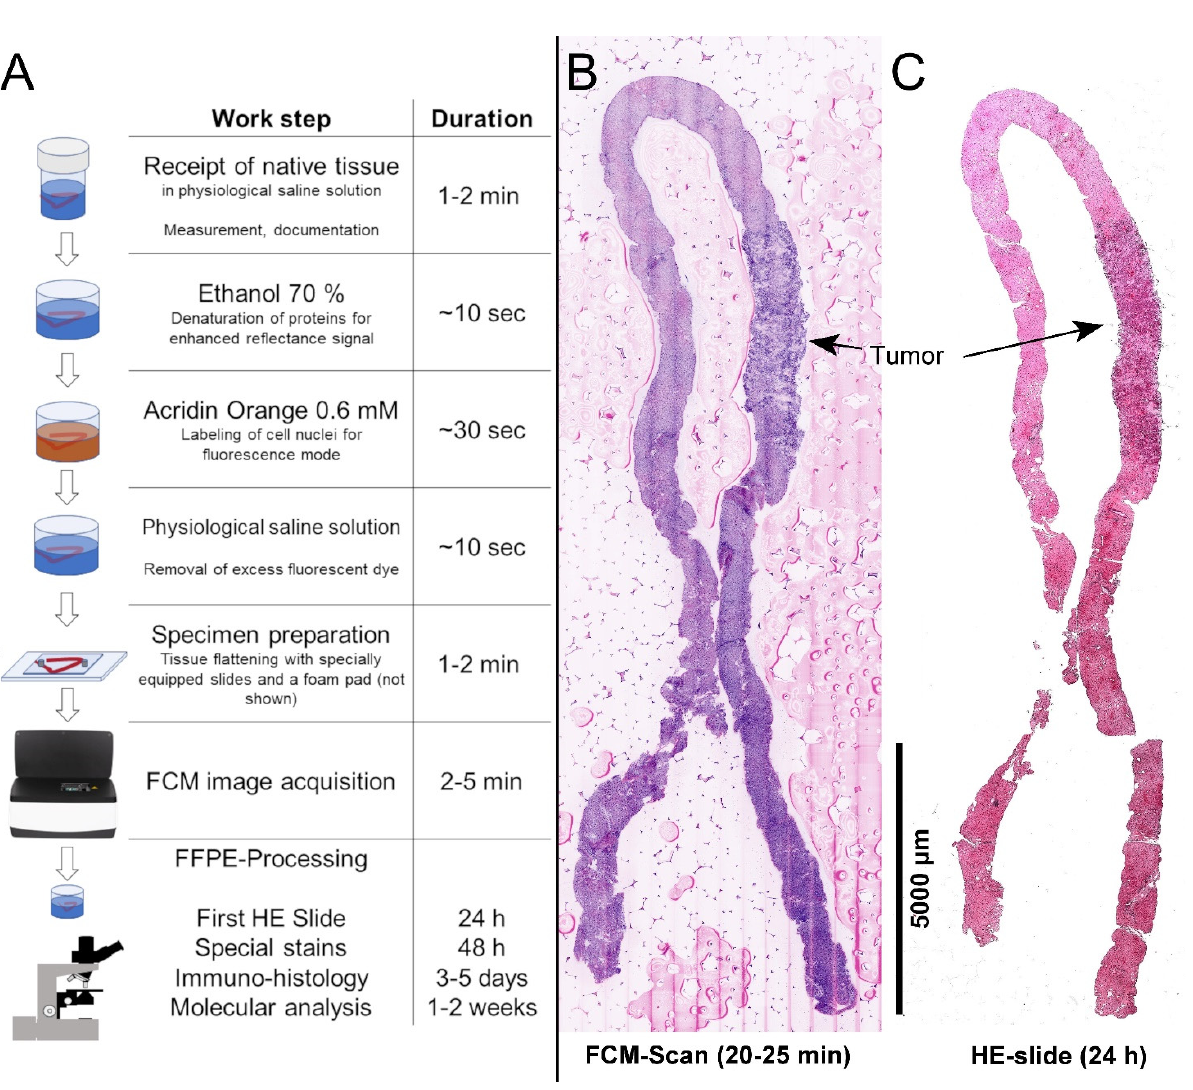
Figure 1. Processing of the native material for FCM. ( A ): The native material was transferred into ethanol, AO and saline solution and finally positioned on a slide specially equipped with magnets.